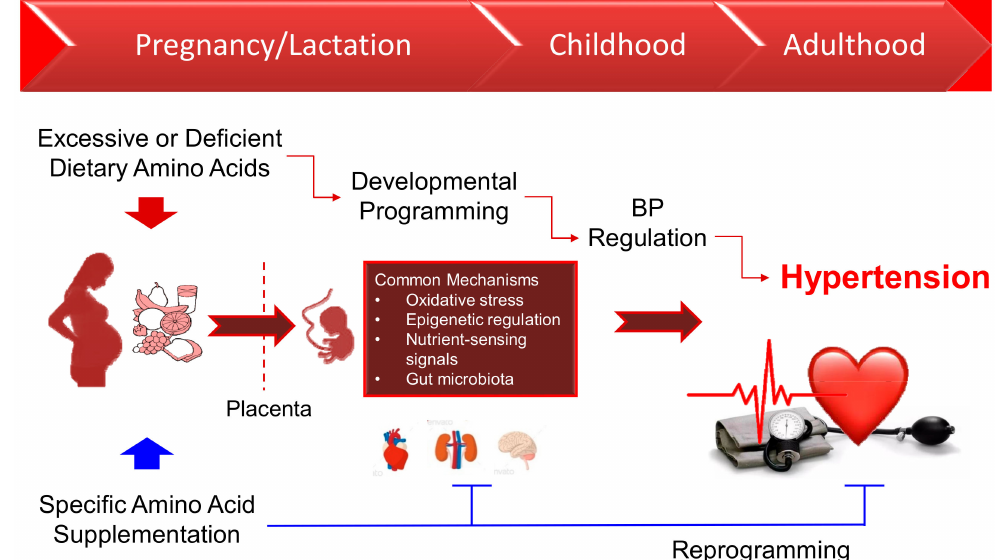
Figure 1. Schematic illustration of the association between amino acid intake in pregnancy, developmental programming, and increased vulnerability to hypertension in adult o ff spring. The solid red arrow line indicates that an oversupply or deficiency of amino acids in pregnancy can lead to developmentalprogrammingofhypertensioninadulto ff spring. Thereareseveralcommonmechanisms, including oxidative stress, epigenetic regulation, nutrient-sensing signals, and gut microbiota involved in this process. The solid blue line indicates the beneficial e ff ects of amino acid supplementation on hypertension of developmental origin. BP, blood